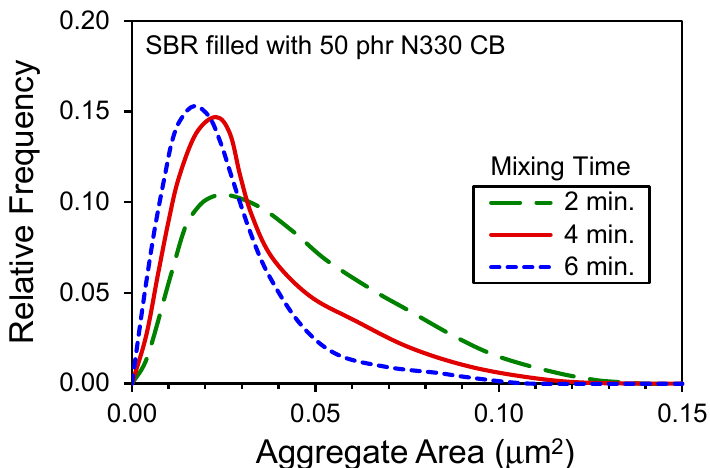
Figure 4. CB aggregate distributions from analysis of TEM images that show progressive aggregate breakage during mixing. Data replotted from Klüppel [8].